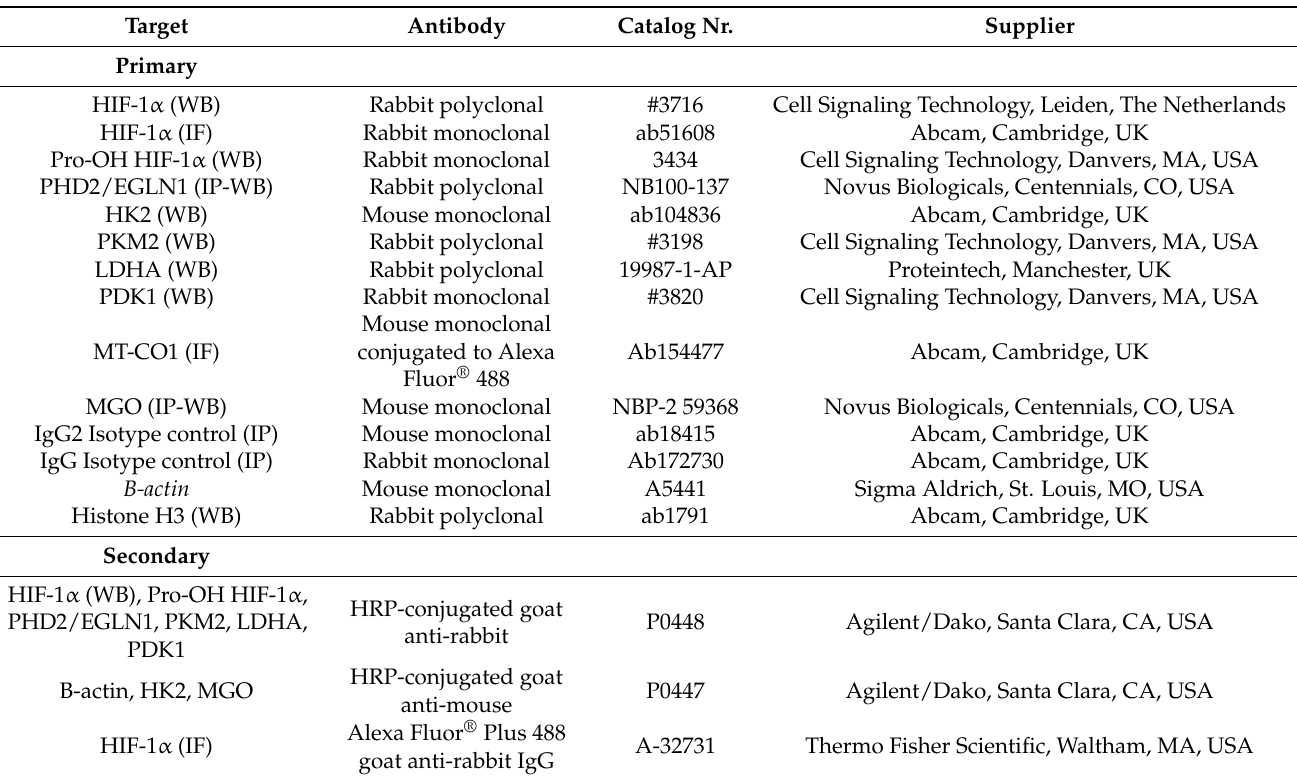
Table 2. Antibodies used in Western blot and IF